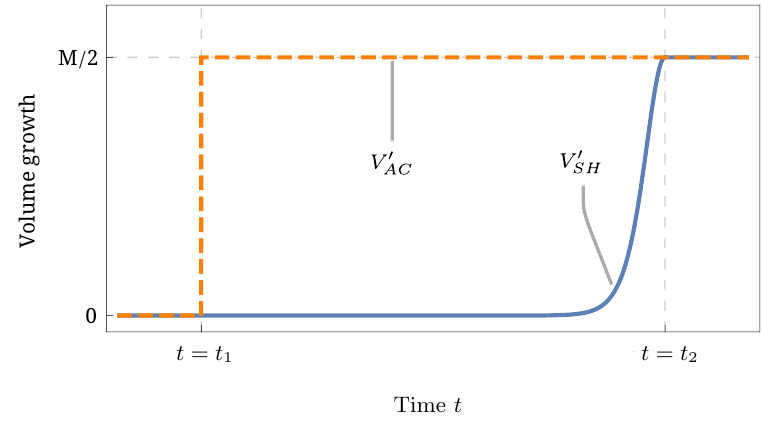
and V 0 . V 0 SH AC AC